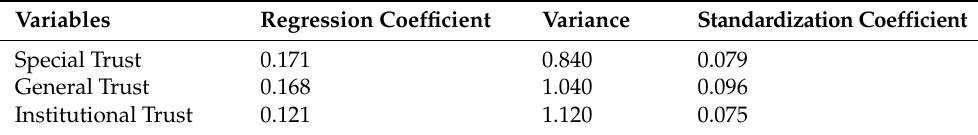
Table 3. Standardized coefficients of trust in different